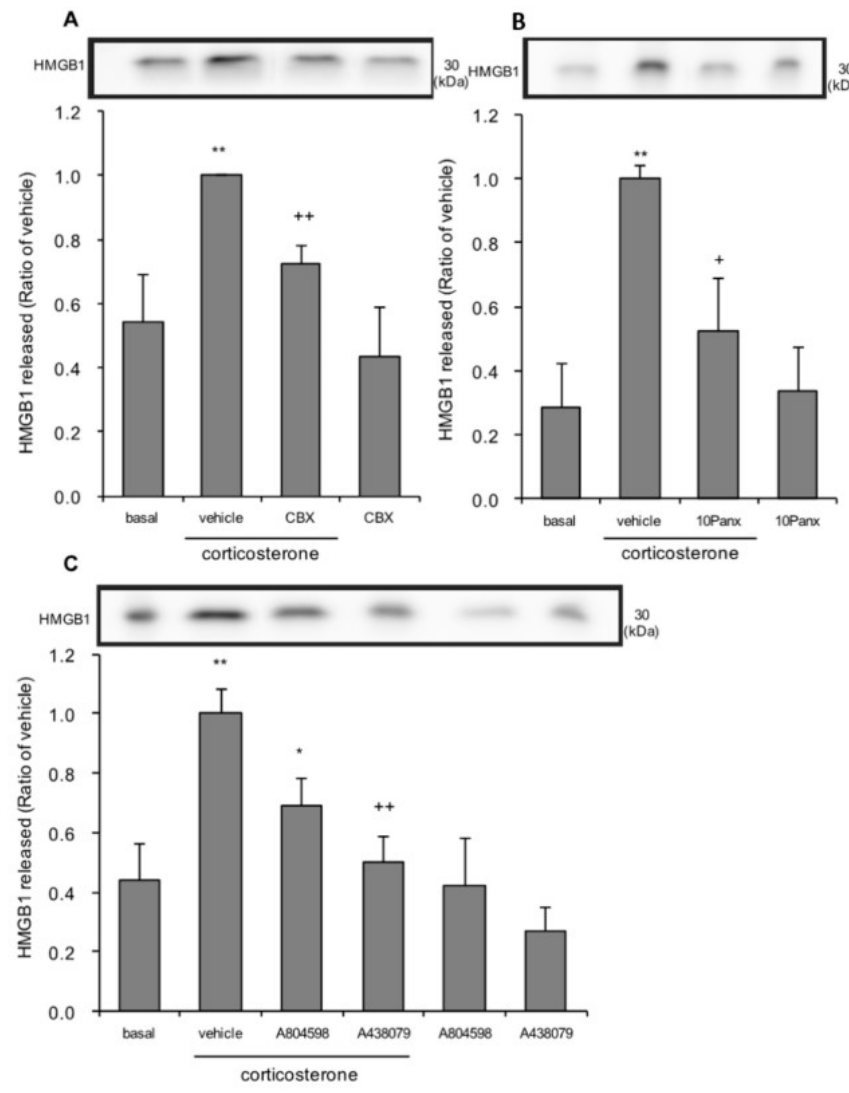
Figure 6. The e ff ects of pannexin-1 inhibitors and P2X7 antagonists on corticosterone-induced HMGB1 release in primary cultured cortical astrocytes. ( A ) Astrocytes were pretreated with 10 µ M carbenoxolone (CBX) for 30 min, and subsequently treated with 1 µ M corticosterone for 24 h. The amount of HMGB1 in the media was quantified by Western blotting. Representative blots are shown (HMGB1: 30 kDa). The data are expressed as the mean ± SEM. ** p < 0.01 vs. basal and ++ p < 0.01 vs. corticosterone alone. (Tukey’s HSD test; n = 6–7). ( B ) Astrocytes were pretreated with 200 µ M 10 Panx overnight, and subsequently treated with 1 µ M corticosterone for 24 h. The amount of HMGB1 in the media was quantified by Western blotting. Representative blots are shown (HMGB1: 30 kDa). The data are expressed as the mean ± SEM. ** p < 0.01 vs. basal and + p < 0.05 vs. corticosterone alone. (Tukey’s HSD test; n = 4–6). ( C ) Astrocytes were pretreated with either 5 µ M A804598 or 5 µ M A438079 for 30 min, and subsequently treated with 1 µ M corticosterone for 24 h. The amount of HMGB1 in the media was quantified by Western blotting. Representative blots are shown (HMGB1: 30 kDa). The data are expressed as the mean ± SEM. ** p < 0.01 vs. basal and * p < 0.05, ++ p < 0.01 vs. corticosterone alone. (Tukey’s HSD test; n =